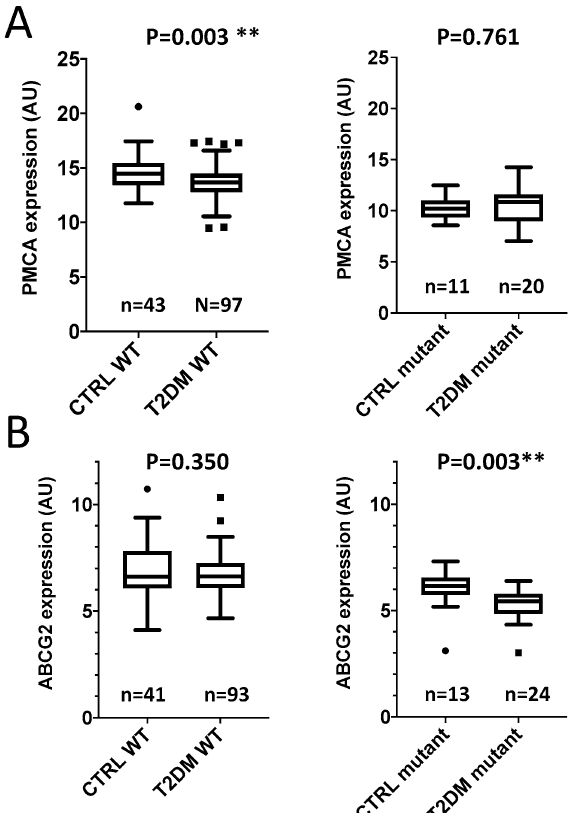
Figure 2. Expression of RBC membrane proteins in age-matched control subjects and in T2DM patients, having different genetic variations. The p values were analyzed by the Mann–Whitney test. ( A ) Expression of the PMCA4b protein, carrying the wild-type haplotype or the minor haplotype in the ATP2B4 gene. ( B ) Expression of the ABCG2 transporter in individuals with the wild-type ABCG2 and those with the ABCG2-Q141K variant. The number of participants (n) is indicated in each